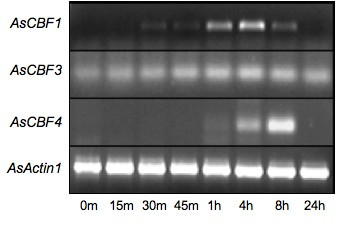
RT-PCR analysis of AsCBF gene expression in three-week old oat. Plants were incubated at +4°C for the times indicated below the lanes (m, minutes; h, hours). Total RNA was isolated from leaves and PCR reactions were run in 30 cycles using AsCBF1, AsCBF3, or AsCBF4 specific primers, as indicated to the left of the picture. Equal loading and RNA quality was controlled by amplification of the oat AsActin1 gene. A 1 kb ladder was used as a size marker (not shown).